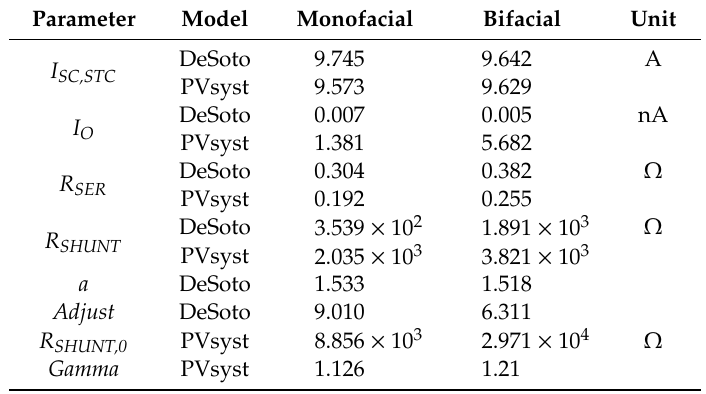
Table A3. Electrical parameters for the two di ff erent versions of the 1-diode model used in the simulations. Please note that the parameter set used for the DeSoto model was extracted from DTU laboratory I-V measurements at STC and that the parameter set used for the PVsyst model was extracted from DTU laboratory measurements at multiple irradiances (200–1000 W · m − 2